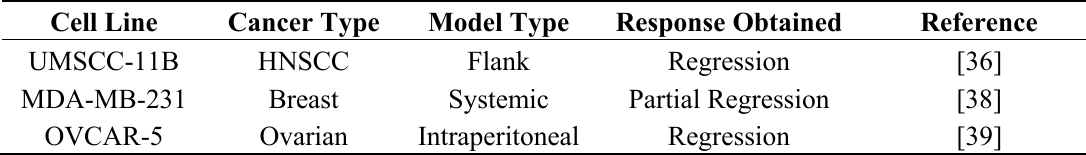
Table 2. A summary of the cancer and model types used to date by our group in evaluating the efficacy of